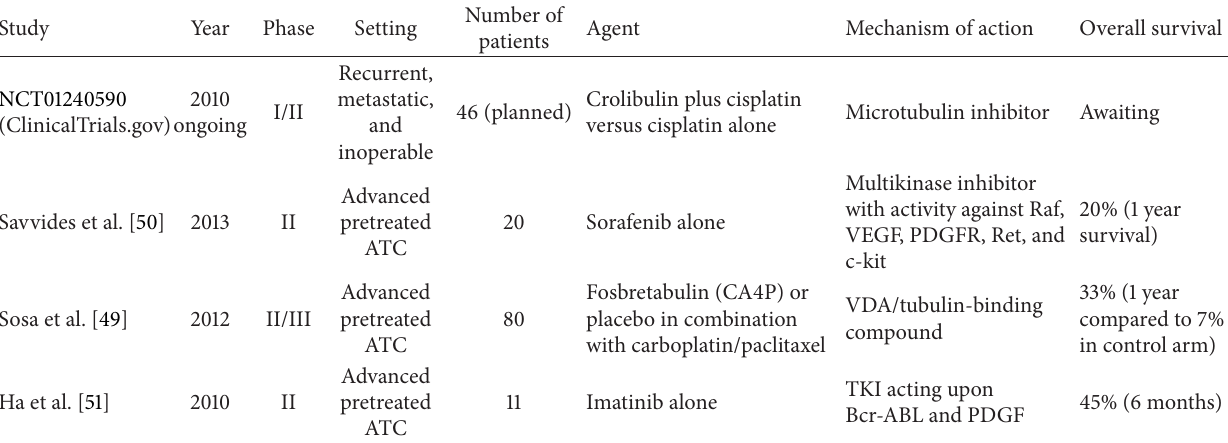
Table 3: Trials using molecular targeting agents in